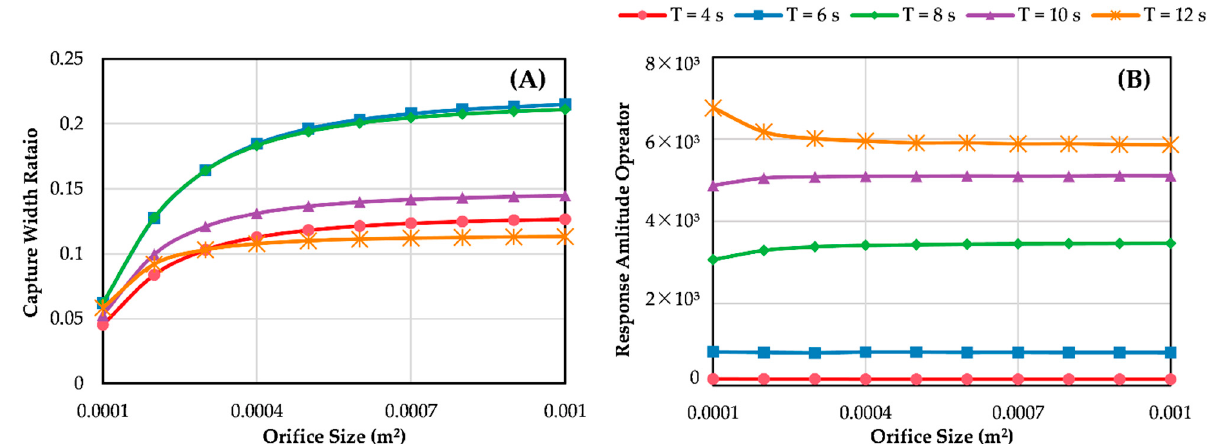
Figure 11. Influence of orifice size of throat valve on the performance of the hybrid system under wave height of 1.5 m. ( A ) Variation of CWR. ( B ) Variation of pitch motion RAO.